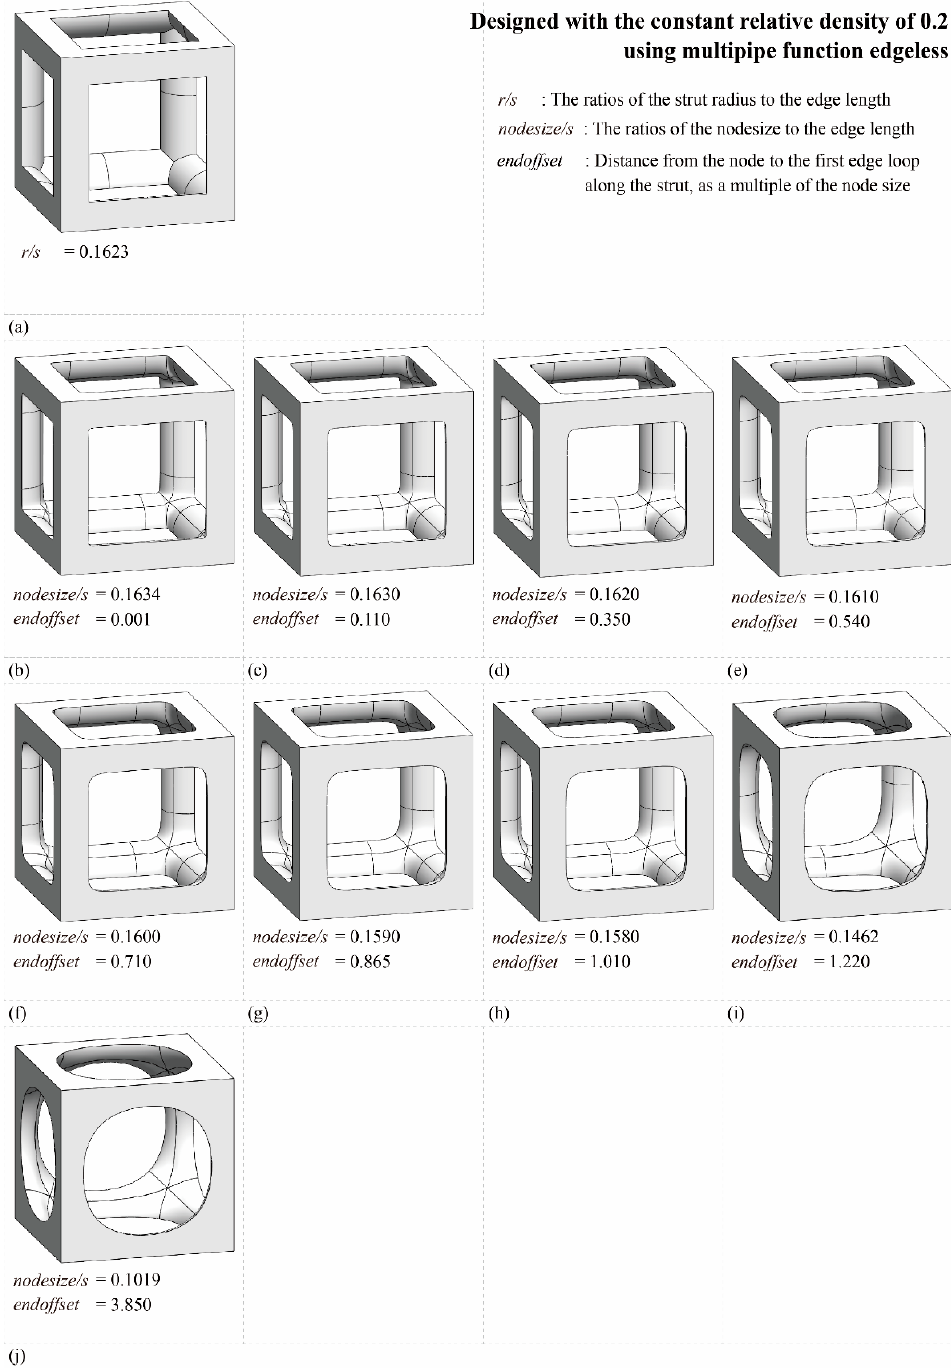
Figure 12. Various morphologies of multipipe edgeless simple cubic unit cells with a relative density of 0.2: ( a ) conventional simple cubic unit cell; ( b – j ) multipipe edgeless simple cubic unit